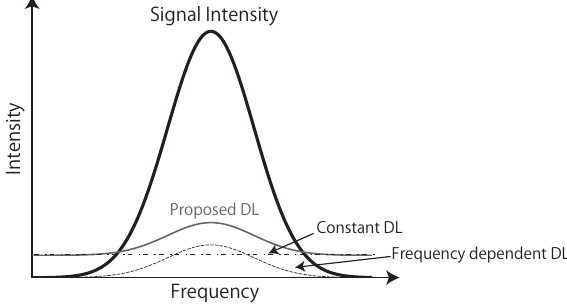
Figure 2. Proposed diagonal loading (DL)